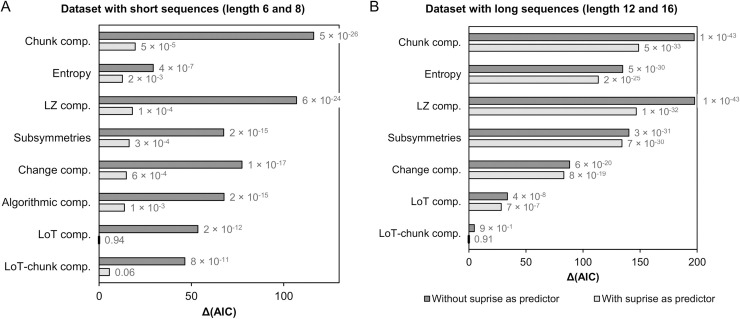
Complementary mixed model comparison with two pooled dataset.A) Δ(AIC) for the sixteen mixed models tested using a dataset including the task performance (LISAS) for sequences of length 6 and 8 (66 sequences) (A), and for the twelve different mixed models tested using the dataset with sequences of length 12 and 16 (22 sequences) (B). The fixed effect of interest is indicated along the vertical axis (all models included participants as a random effect and could include surprise as a covariate—light gray bars). Akaike weight for each model is also reported.